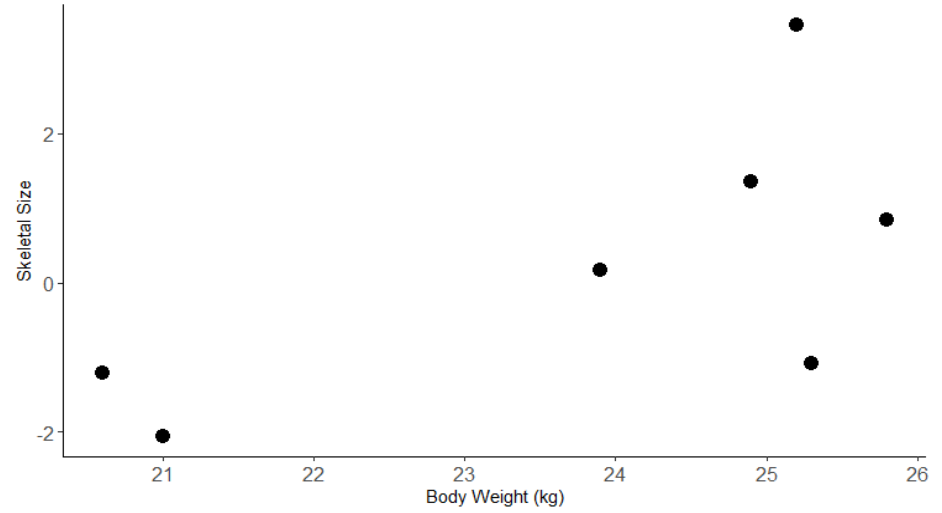
Figure 2. Plot of skeletal size variable against the bodyweight of the seven participating Huntaway dogs. Skeletal size was a variable calculated with the eigenvalues from six morphometric measurements taken of the body.